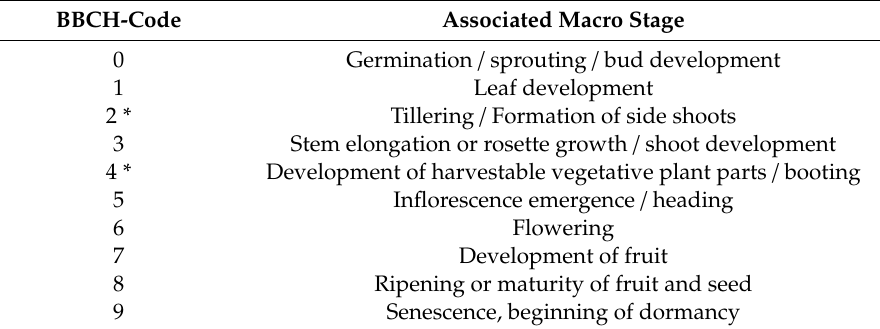
Table 4. Macro stages of the BBCH-scale. Adapted from Table 1 in Bleiholder et al.